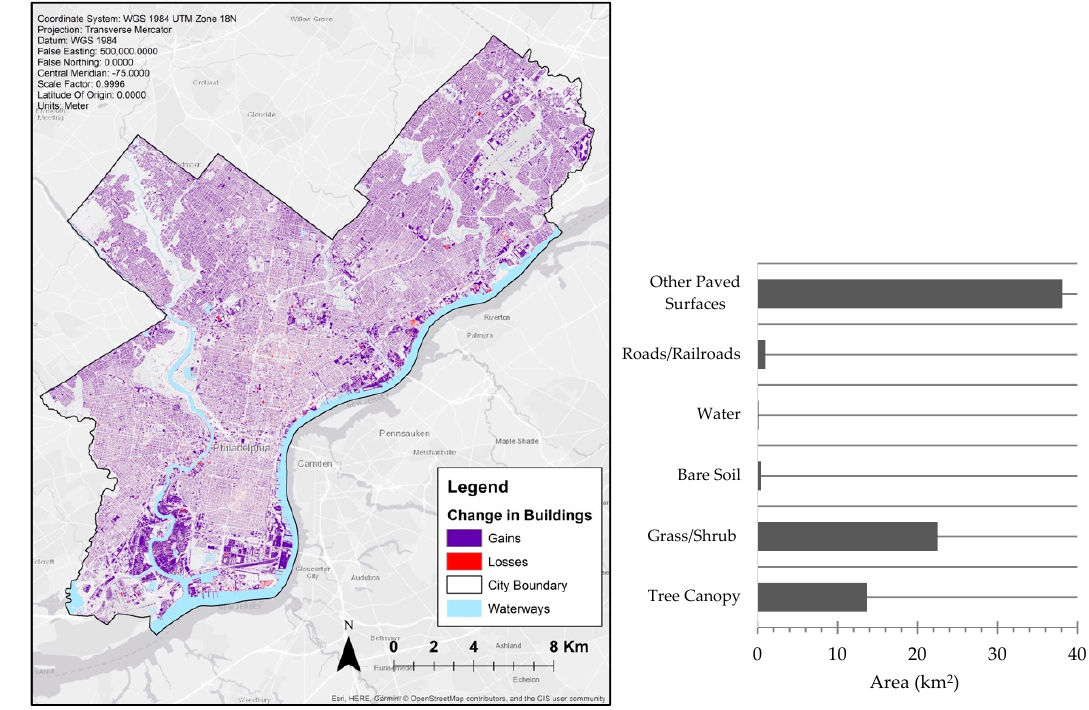
Figure 8. Changes in buildings from 2008 to 2036. Left: Map of change in buildings. Right: Contributions to increases in buildings.